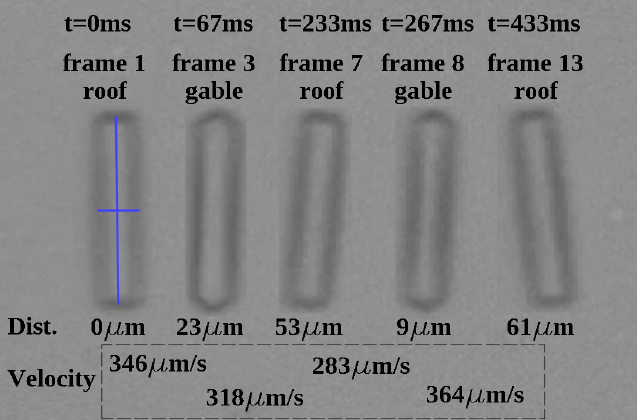
Figure 8. Experimental crystal translation/rotation for Q = 40 µ